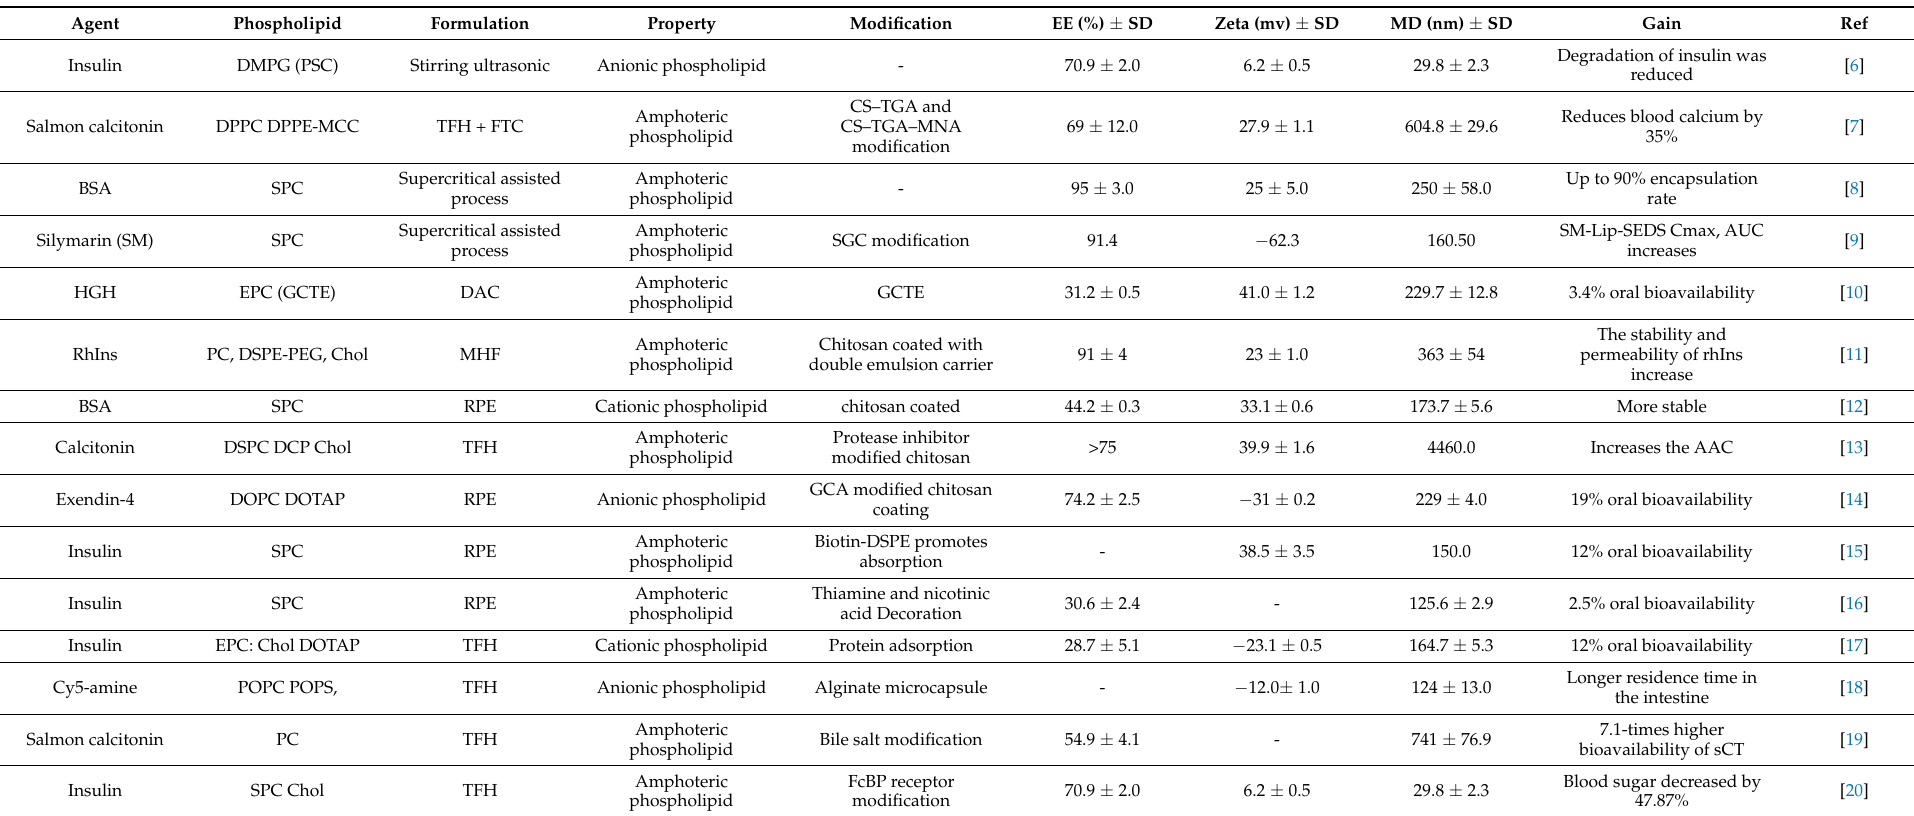
Table 1. Characteristics of previously reported oral